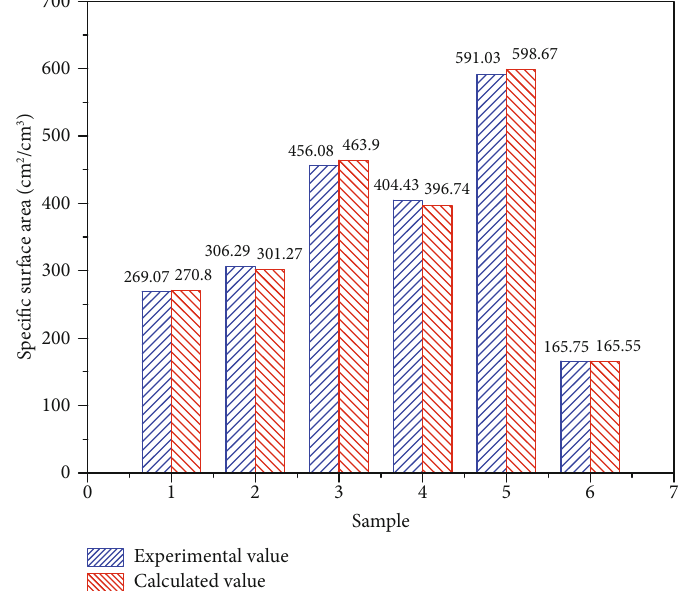
Figure 6: Comparison of experimental and calculated values of foamed copper speci fi c surface area.